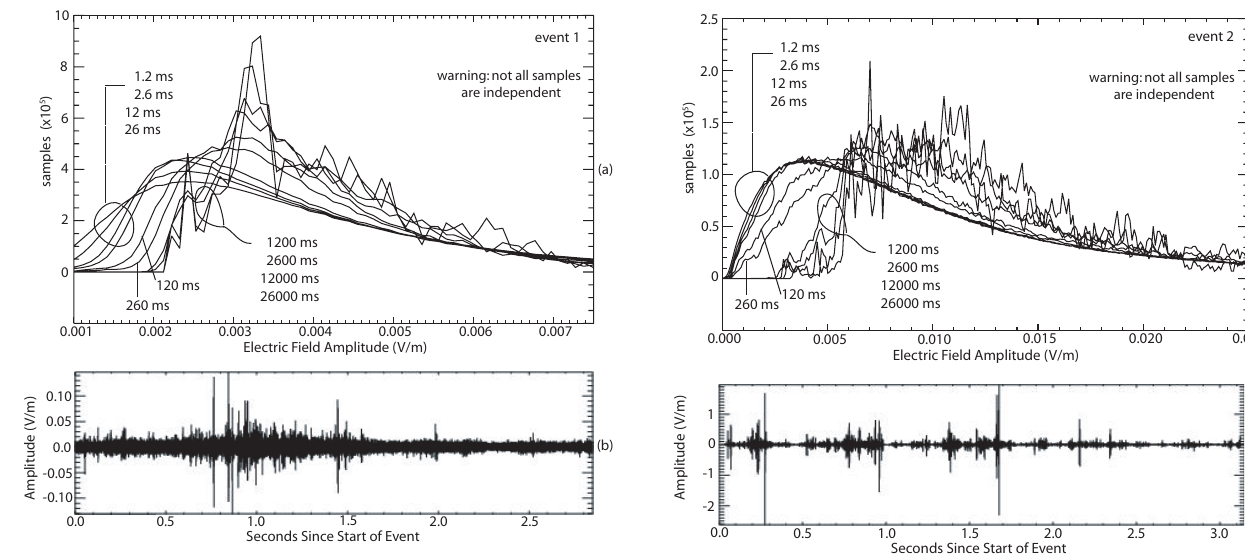
Fig. 3. Time series and histogram of running-averaged samples for the Langmuir burst denoted as event 2 in Figure 1b, in the same format as Figure 2.